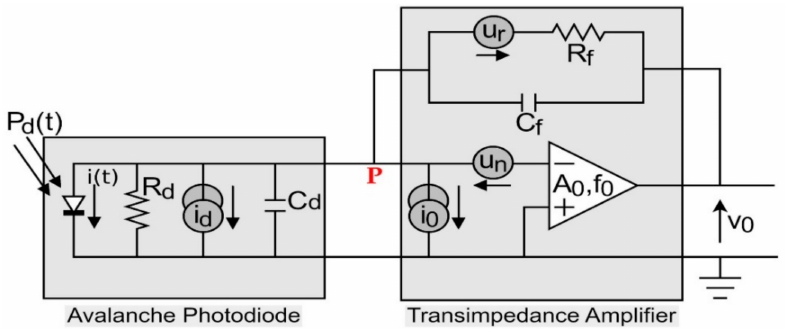
Figure A1. Electric diagram for the APD and the